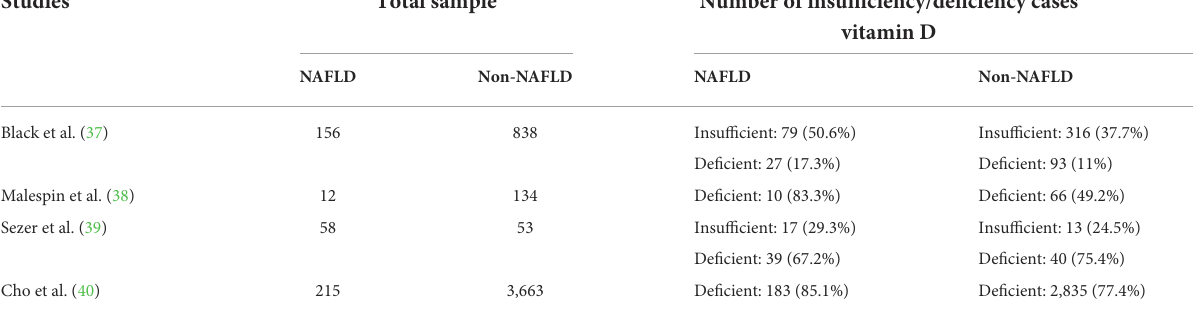
TABLE 1 Table of the proportion of cases of vitamin D insufficiency or deficiency in obese children with NAFLD and obese children without NAFLD.